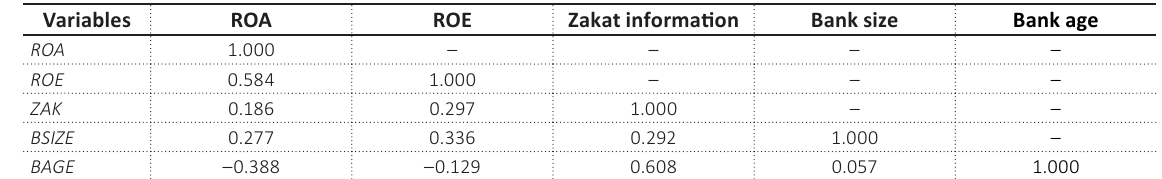
Table 3. Correlation matrix